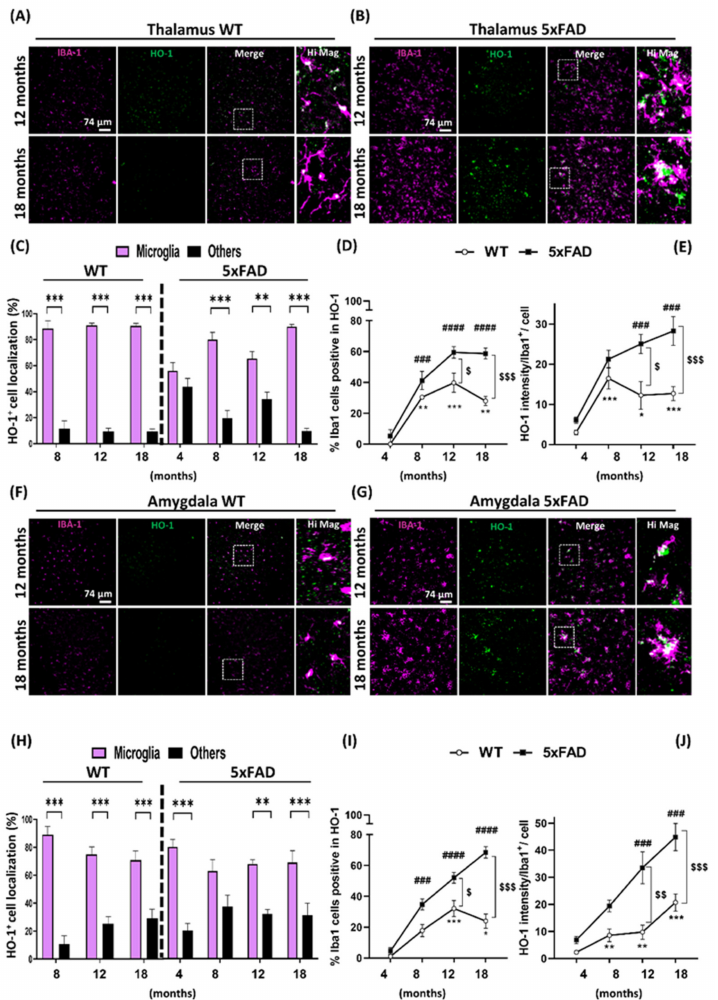
Figure 3. Microglial HO-1 is overexpressed in the thalamus and amygdala with aging in 5xFAD. ( A , B ) Representative immunofluorescence images taken with an objective 40x of Iba1 + microglia (magenta) andHO-1(green)andthemergeimage(white)inthethalamusofWTand5xFADmiceat12and18monthsof age. ( C ) Specific cell localization of HO-1 + staining in microglia (magenta) or other cells (black) expressed as percentage in the thalamus of WT or 5xFAD mice at the different ages; ** p < 0.002 and *** p < 0.001 compared to the percentage of HO-1 + staining in microglia. ( D ) Percentage of total microglial cells expressing HO-1 in WT and 5xFAD mice at different ages. ( E ) Amount of HO-1 expressed per Iba1 + microglia cell with aging in WT and 5xFAD mice; ** p < 0.002 and *** p < 0.001 compared to 4 months WT mice; ### p < 0.002 compared to 4-month-old 5xFAD; $ p < 0.03 and $$$ p < 0.001 5xFAD mice compared to aged-match WT controls. 40x representative immunofluorescence images in the brain thalamus of WT ( F ) and 5xFAD ( G ) mice at 12and 18 months old. ( H ) Specific cell localization of HO-1 + staining in microglia (magenta) or other cells (black) expressed as percentage in the amygdala of WT or 5xFAD mice at the different ages; ** p < 0.03 and *** p < 0.002 compared to the percentage of HO-1 + staining in microglia. ( I ) Percentage of microglial cells expressing HO-1 in WT and 5xFAD mice at different ages. ( J ) Mean intensity of HO-1 per Iba1 + microglia in WT and 5xFAD mice with aging; * p < 0.03, ** p < 0.002 and *** p < 0.001 compared to 4-month-old WT mice; ### p < 0.001 compared to 4-month-old 5xFAD; $ p < 0.03, $$ p < 0.002 and $$$ p < 0.001 5xFAD mice compared to aged-match WT controls. Data represent mean ± S.E.M. ( N =